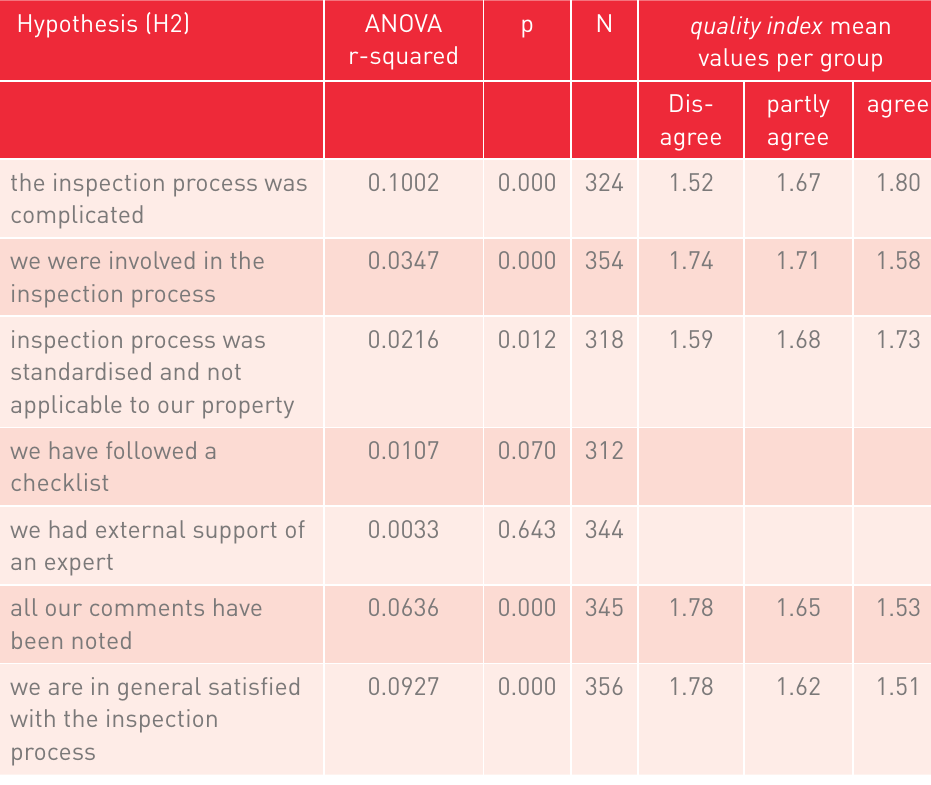
Perception of building quality (mean values), in relation to the inspection